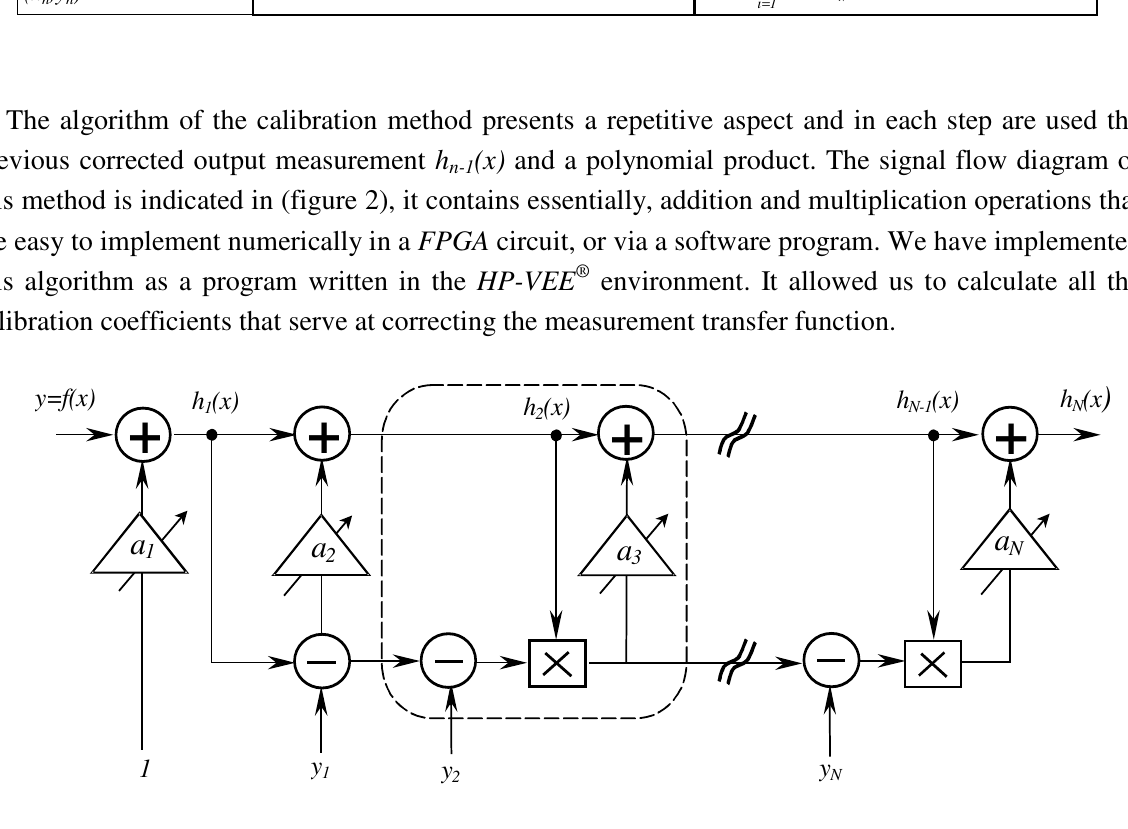
Figure 2. Signal flow diagram of the progressive calibration